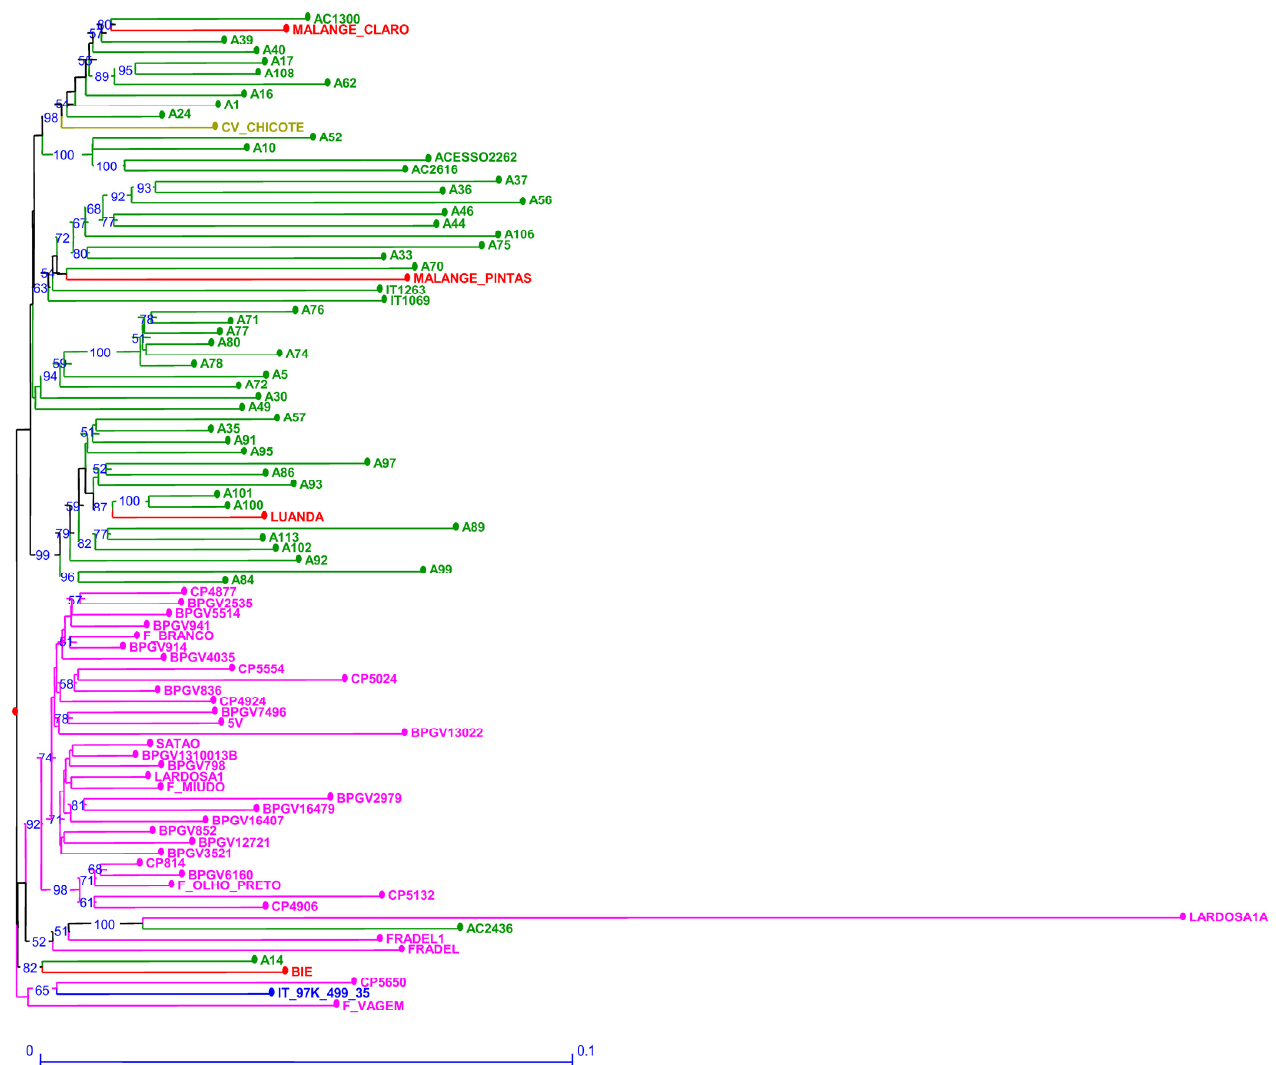
Figure 4. Neighbor joining dendrogram of cowpea genotypes, identified by SNP markers. Numbers associated with branches indicate bootstrap values (BS) based on 20,000 replications. Only BS values above 50 are shown. Branch lines represent individual accessions grouped by country (red: Angola, olive green: Cape Verde; green: Mozambique; blue: Nigeria and pink: Portugal).